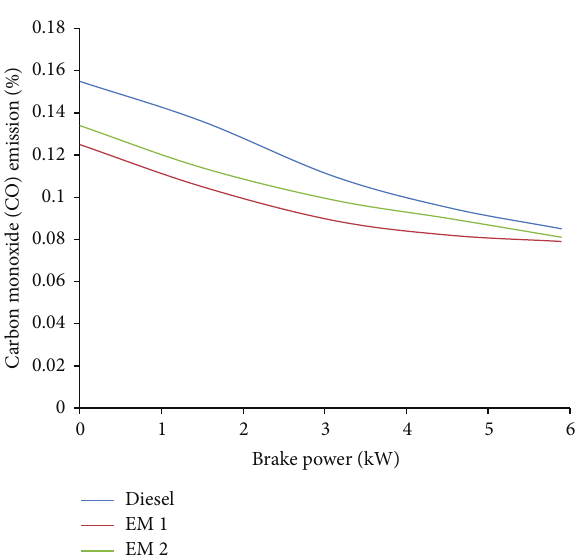
Figure 5: Brake power versus smoke opacity emission.